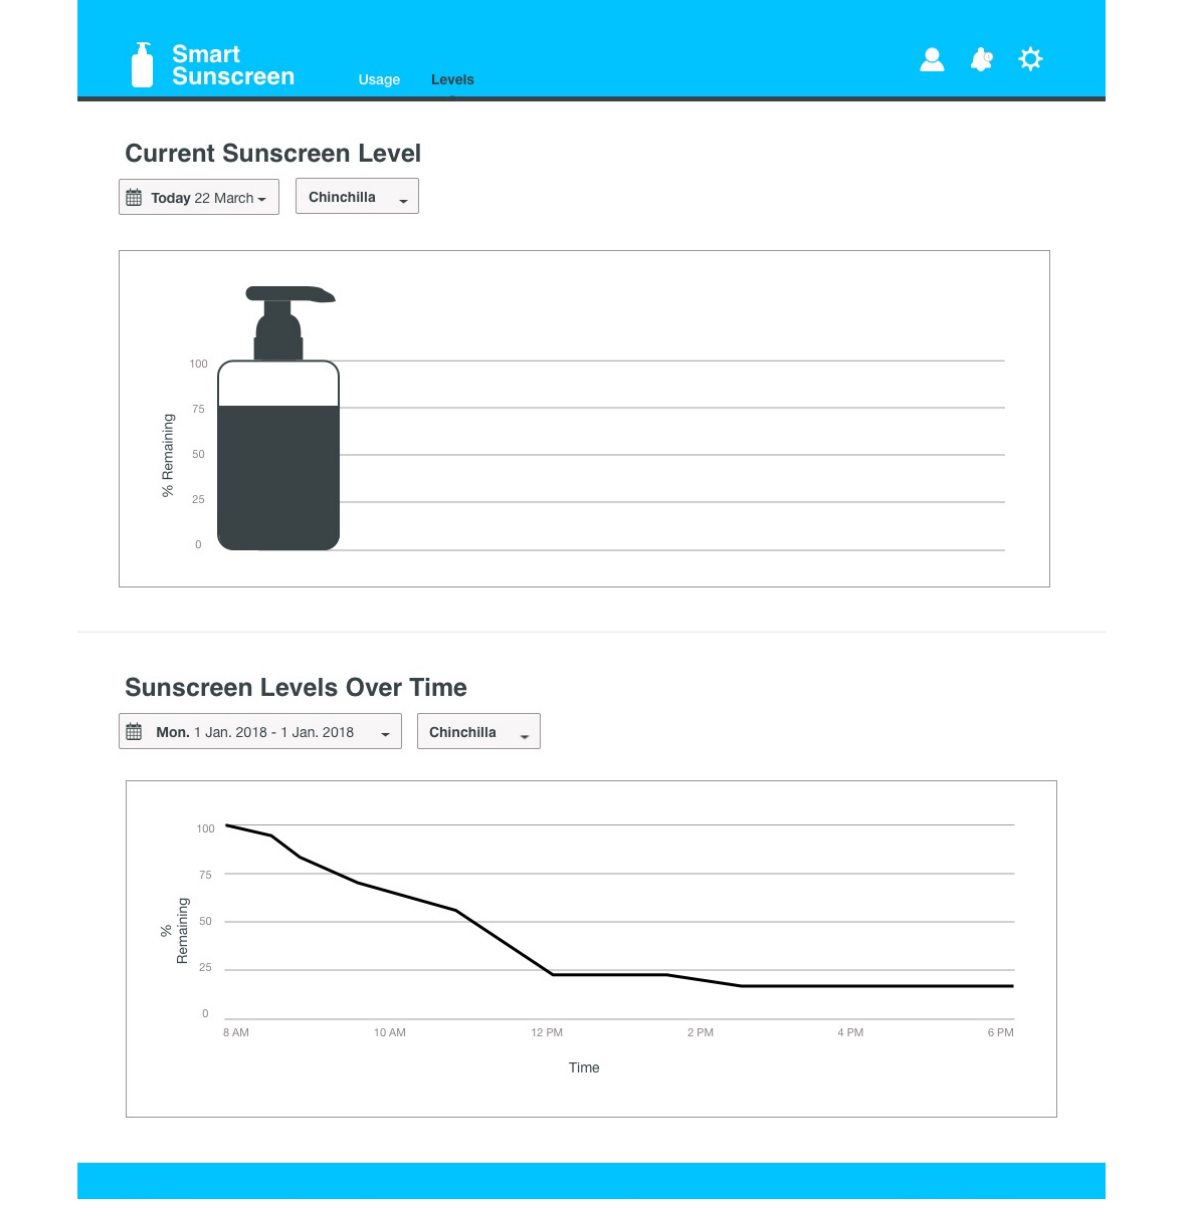
Figure 8. Smart sunscreen station dashboard data showing the current sunscreen bottle level the level of sunscreen in the bottle over